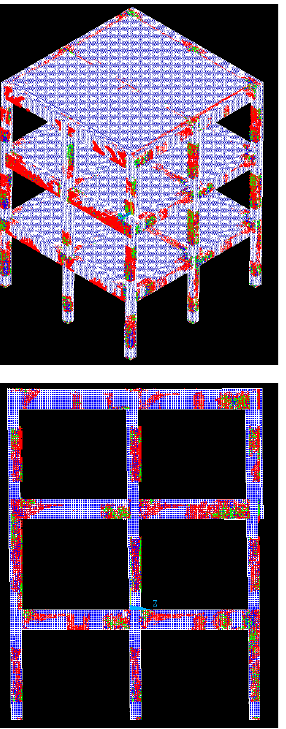
Figure 11. Analytical Crack Development Fig. 11. Analytical crack